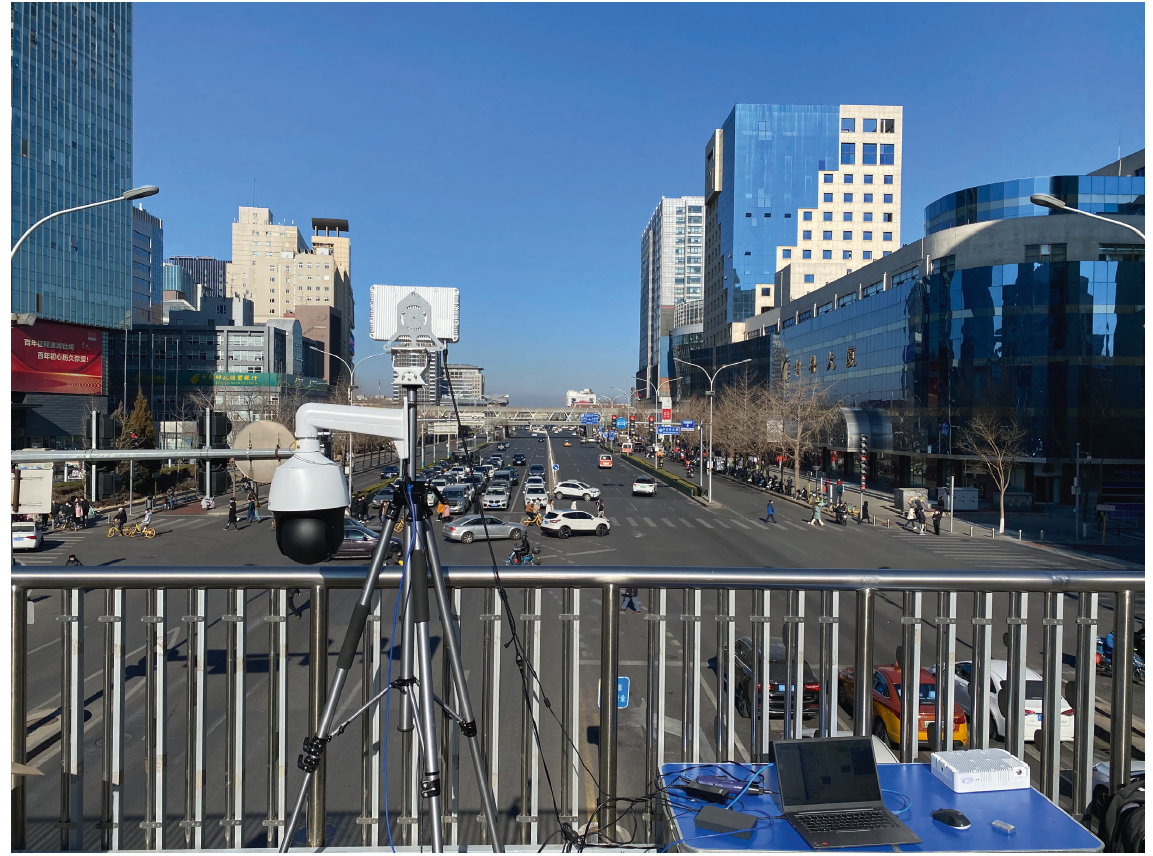
Figure 10: Crossroad scenario in day